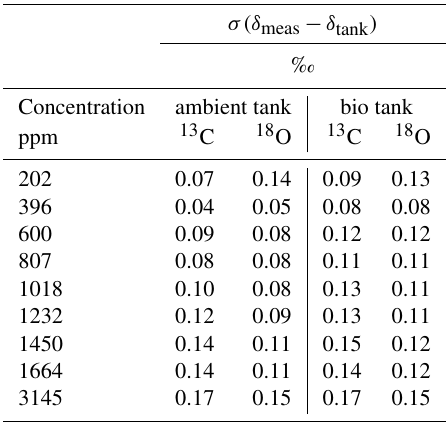
Table 7. Standard deviations σ of the measured (calibrated) δ val- ues over a large concentration range based on 6-hourly lab measure- ments over a period of 9